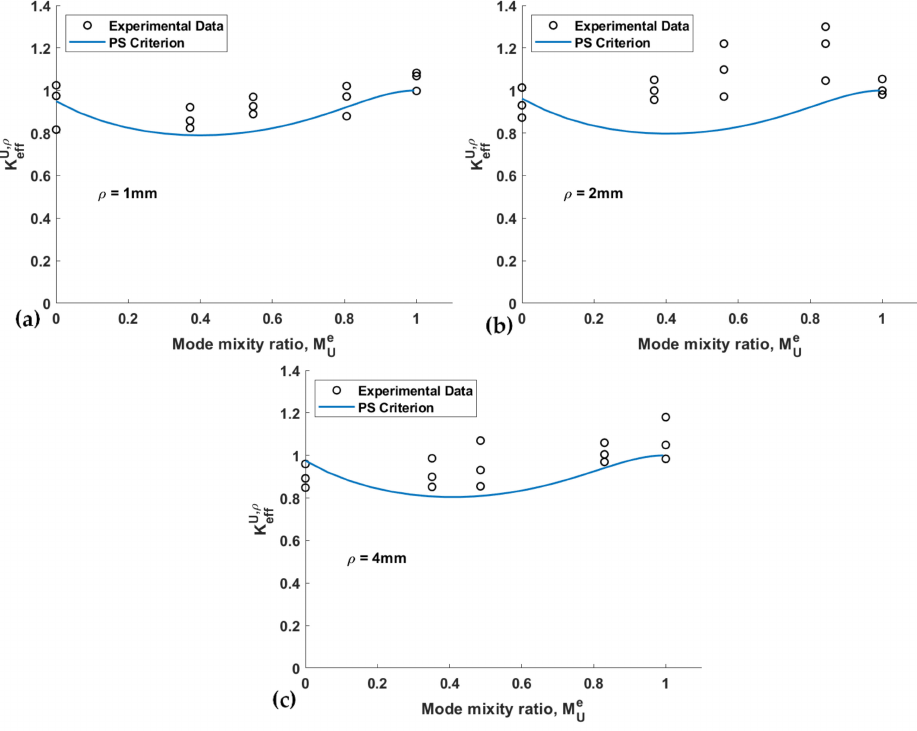
Figure 10. Effective normalized fracture resistance predictions vs. mode mixity ratio when using the PS criterion and corresponding experimental data. ( a ) ρ = 1 mm; ( b ) ρ = 2 mm; ( c ) ρ = 4 mm.